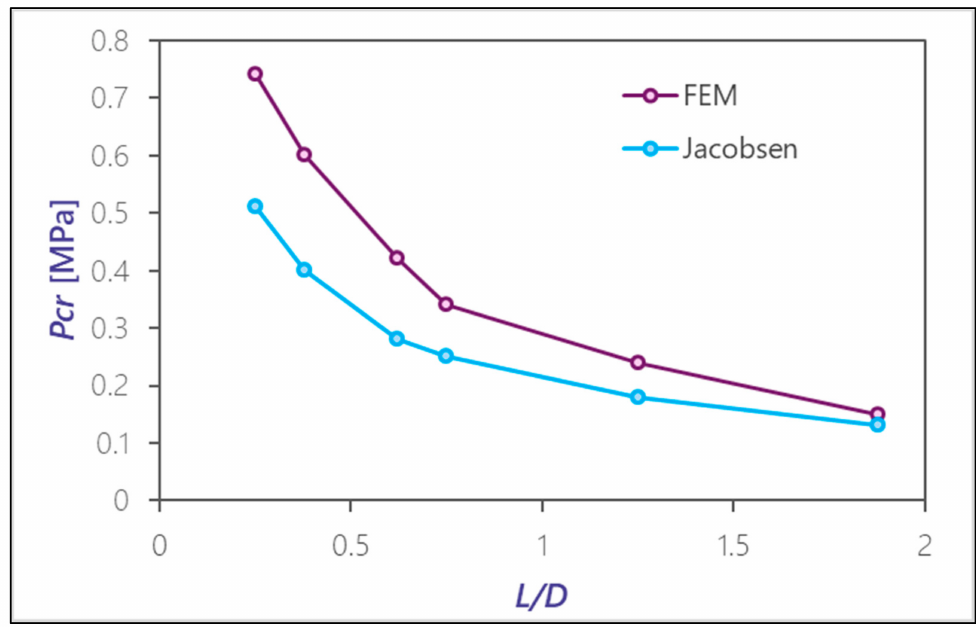
Figure 14. Comparison of Jacobsen values with FEM results versus L / D .